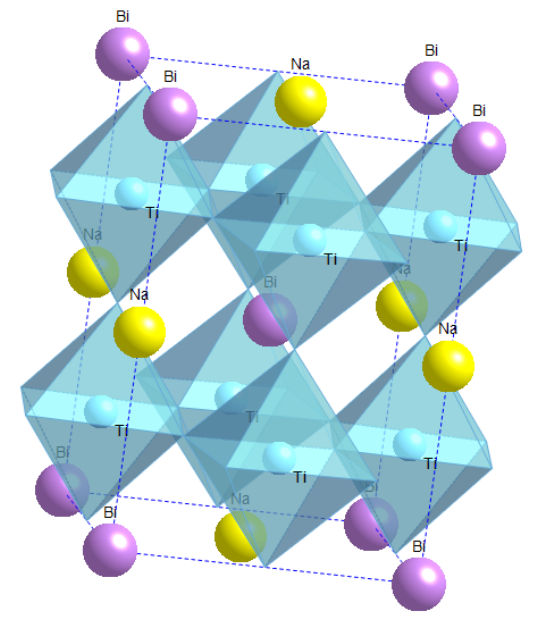
Figure 3. Schematic of the pseudo-cubic NBT perovskite structure. The structure illustrated is locally ordered on the A-site (Bi, Na), although the extent of ordering is not well known. The oxygen atoms are not shown for clarity and their positions are instead represented by the oxygen